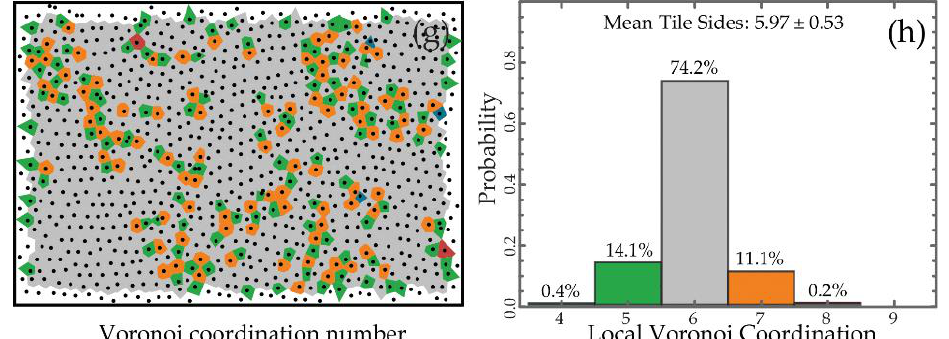
Figure A4. Spatial statistics of sedimented SiPs60. ( a ) SEM image with insert of coordination map or fast Fourier transform (FFT) showing six lobes as expected for hexagonally packed systems. However, the smearing suggests a more powder like disordered configuration rather than sharp lobes. ( b ) pair correlation function for the particle distributions (blue) and that of the matched hexatic lattice (grey). Using the average spacing (2r hex ) of a hexagonal lattice with the same number density (located at particle positions), the matched hexatic lattice is determined by randomly displacing the particles from their center with a mean distance relative to a normal probability distribution. The widths of these peaks correspond to the average mean displacement each particle has relative to this expected spacing, described by the lattice disorder parameter, σ . The nearest neighbor distance can be determined from the maximum of the first peak in the g(r) . The insert above shows the difference spectrum, which is the subtraction between the pair correlation function and the hexatic lattice. ( c ) Voronoi tessellations of the particle centroids colored by percent deviation of the expected cell area produced from hexagonal packing. ( d ) Histogram of the probabilities of various percent deviations of the Voronoi cell areas from those produced from hexagonal packing. Taking into account cells with packing of less than 15% of a perfect hexagonal lattice (three blue bars), the film shows 76.5% hexagonal packing regions. ( e ) Voronoi tessellations of the particle centroids colored by the normalized bond order parameter. Whiter areas indicate particles that have high angular order in a hexagonal ( q 6 ) symmetry basis. ( f ) Histogram of the probabilities for various values of the bond order parameter. The extracted global bond order parameter is 0.727 q/q6 (i.e., 73% of perfect